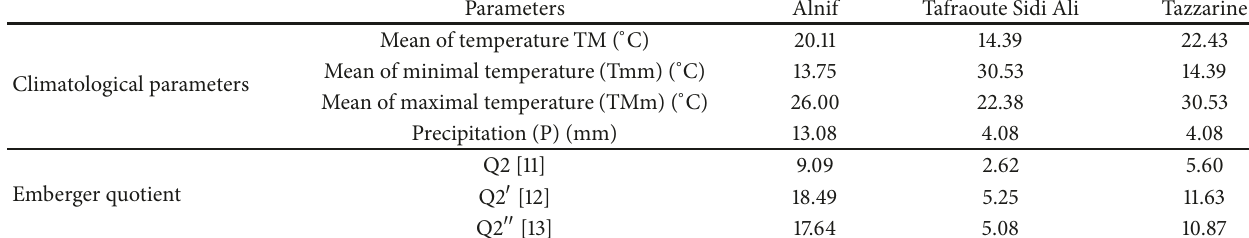
Table 4: Climatological analysis of the three Henna varieties studied. Parameters